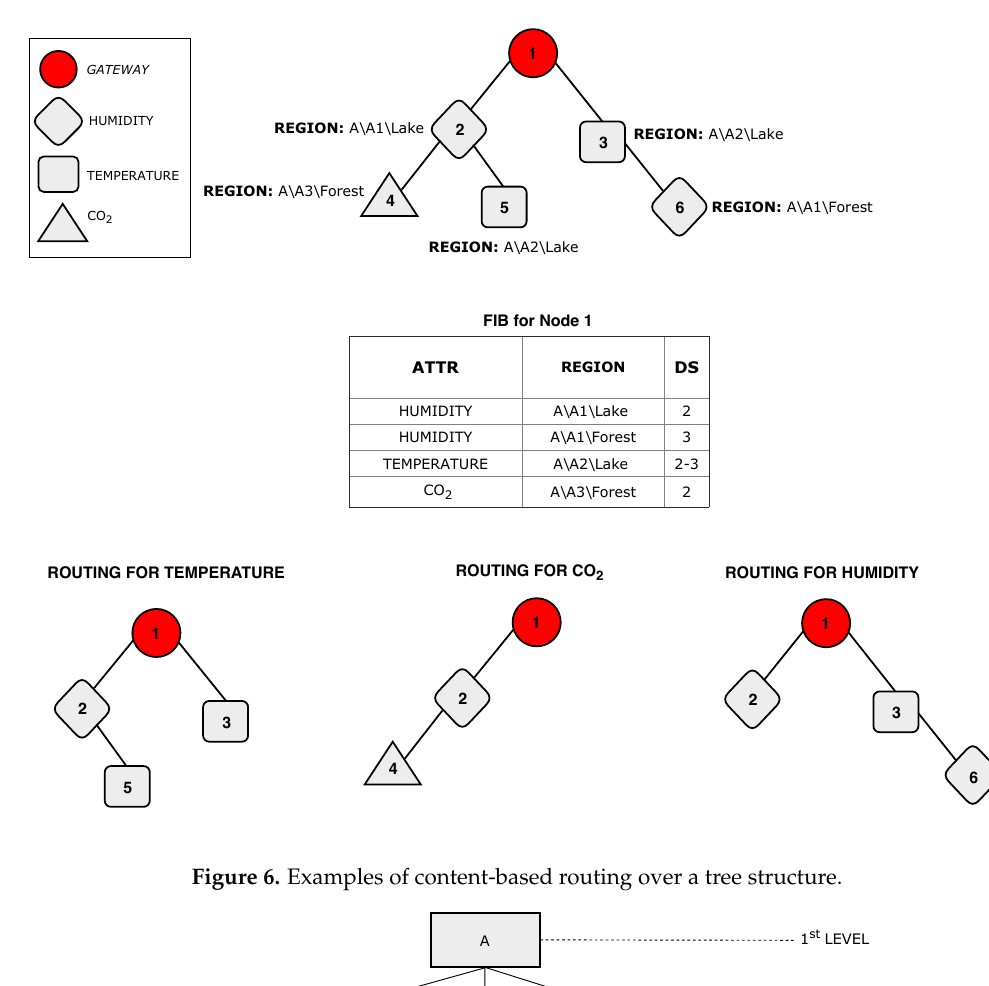
Figure 6. Examples of content-based routing over a tree structure.